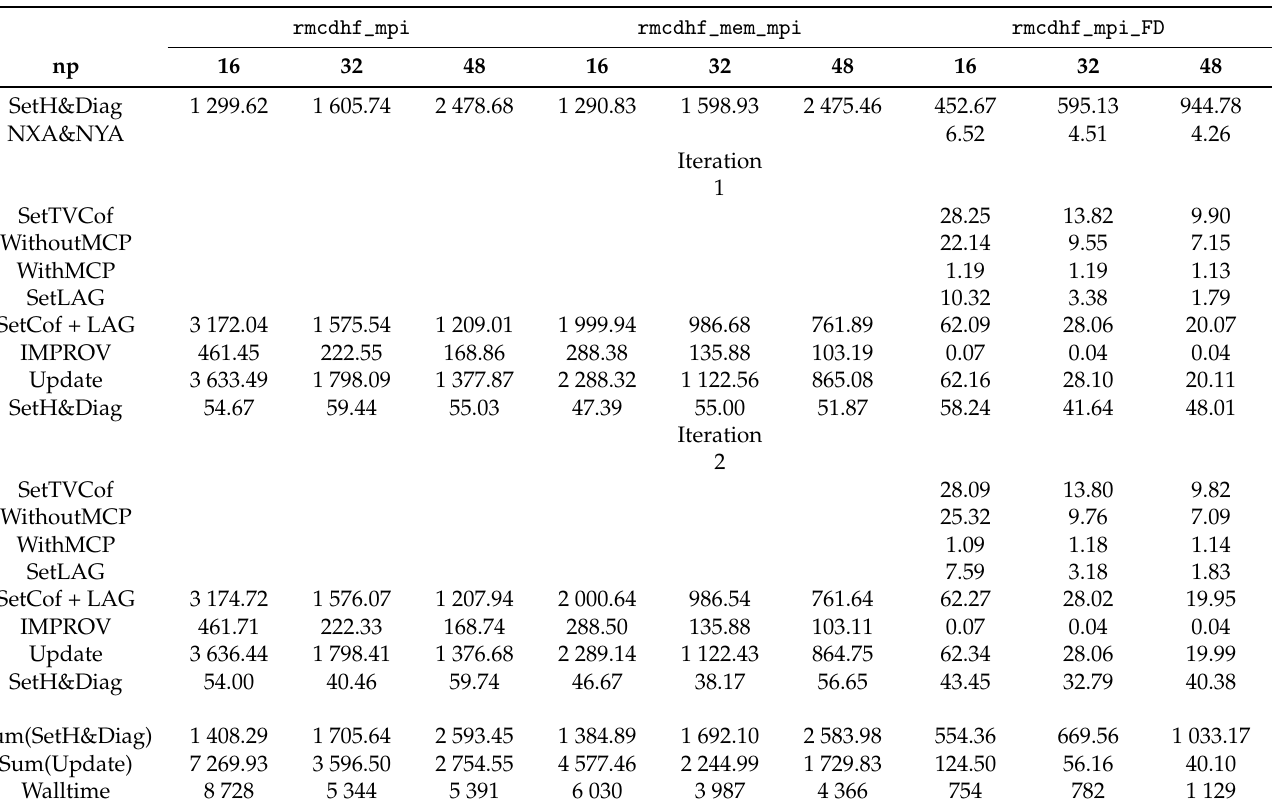
Table 3. CPU times (in s) for the Mg VII AS 5 SCF calculations using the rmcdhf_mpi , rmcdhf_mem_mpi and rmcdhf_mpi_FD codes as a function of the number of MPI processes ( np ). See text for